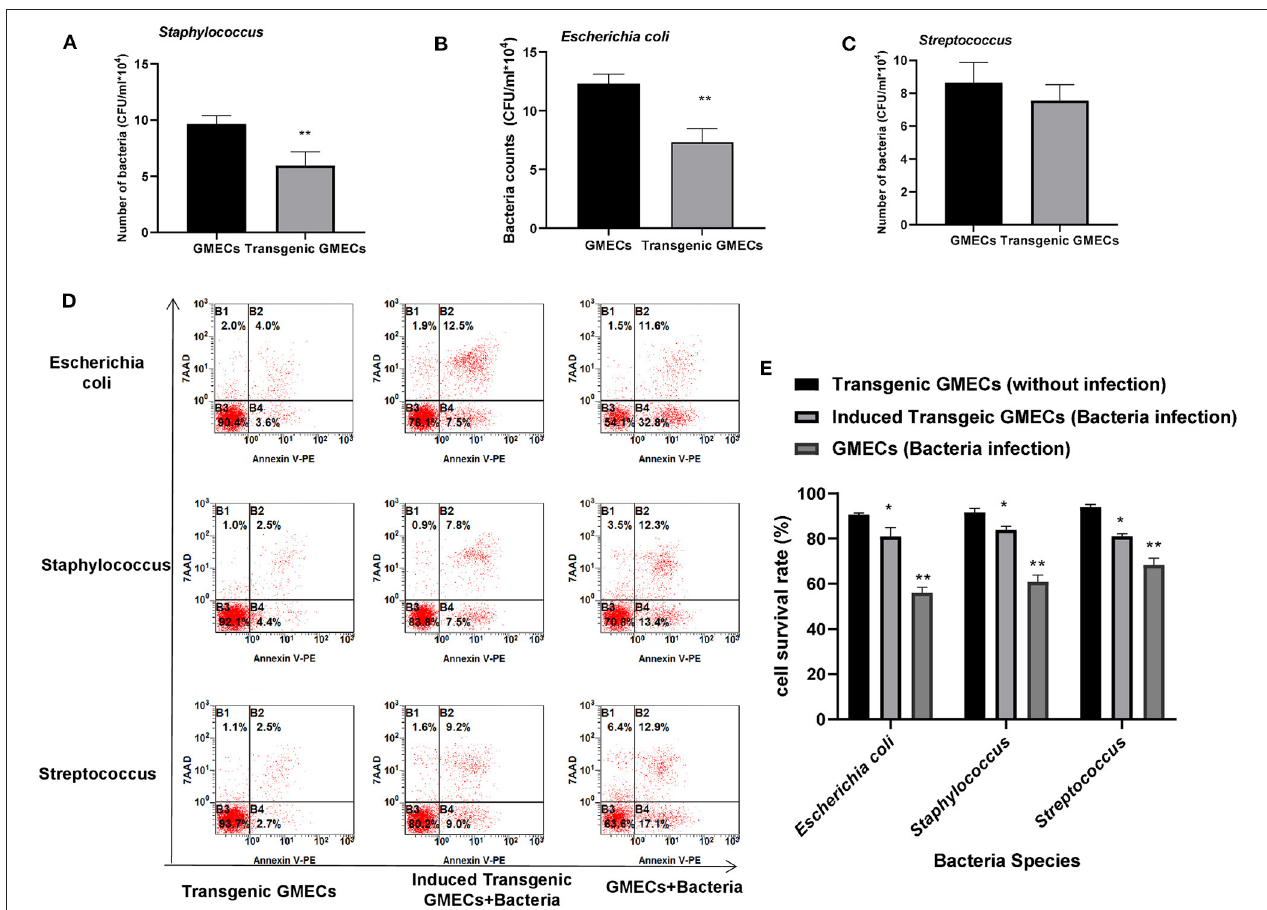
FIGURE 4 | Anti-bacterial capacity of transgenic monoclonal goat mammary gland epithelial cells (GMECs) that expressed and secreted interferon-gamma (IFN- γ ) protein. (A–C) Bacterial challenge of transgenic GMECs was performed to assess the anti-bacterial capacity of IFN- γ . Transgenic GMECs showed much stronger Staphylococcus and Escherichia coli resistant activity than the non-transgenic ones ( P < 0.01), but no obvious differences in anti- Streptococcus effects. (D,E) Survival rate of GMECs in different bacteria-treated cells at 6h; transgenic GMECs obviously increased the survival rate over non-transgenic ones ( P < 0.05). * p < 0.05, ** p <